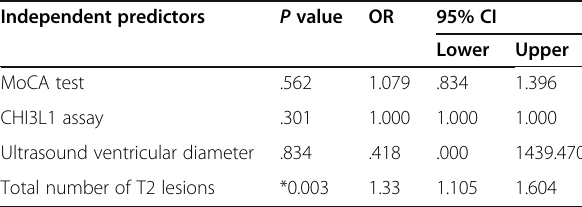
Table 4 Logistic regression to detect predictors of early conversion to